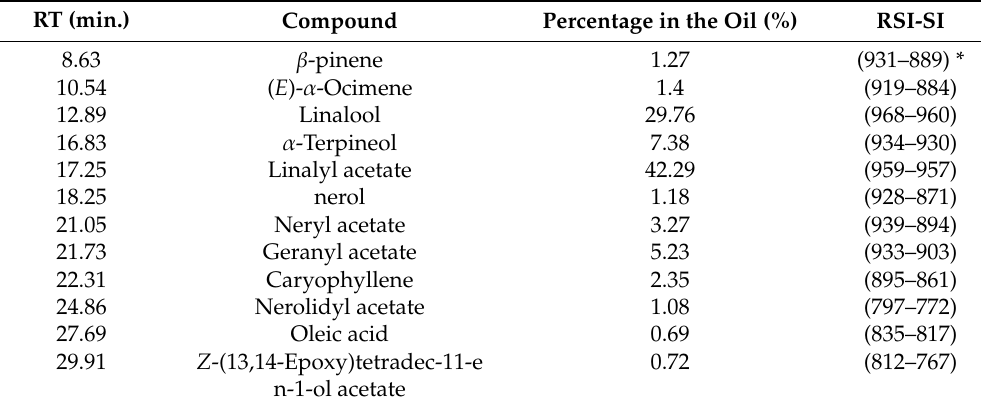
Table 3. Phytochemical composition of C. aurantium essential oil by GC / MS.